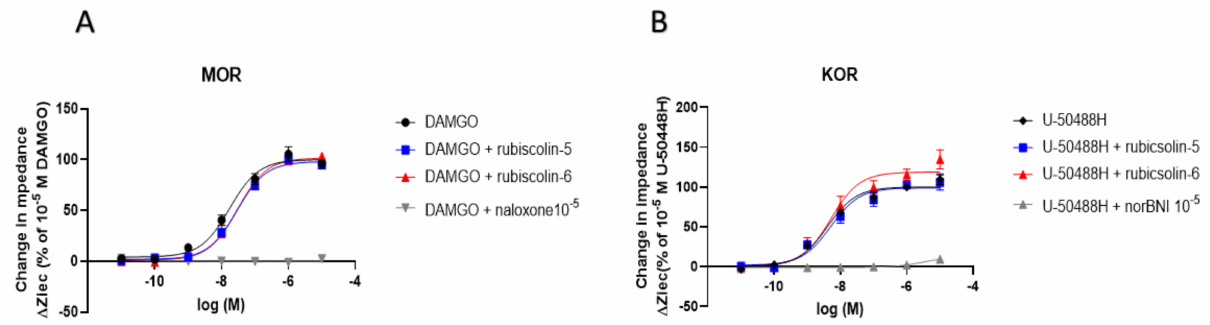
Figure 3. Evaluation of antagonistic effects induced by rubiscolins combined with positive control for MOR or KOR, observed using the CellKey TM system. The cells expressing MOR ( A ) and KOR ( B ) were treated with each positive control alone or in combination with rubiscolin-5, rubiscolin-6, or 10 − 5 concentration of each negative control (10 − 11 –10 − 5 M), and changes in impedance ( ∆ Ziec) were measured using the CellKey TM system. Concentration–response curves were prepared by calculating ∆ Ziec relative to the data obtained for each positive control: 10 − 5 M DAMGO for MOR ( A ) and 10 − 5 M U-50488H for KOR ( B ). All data points are presented as means ± S.E.M. for three independent experiments ( n = 3–4).